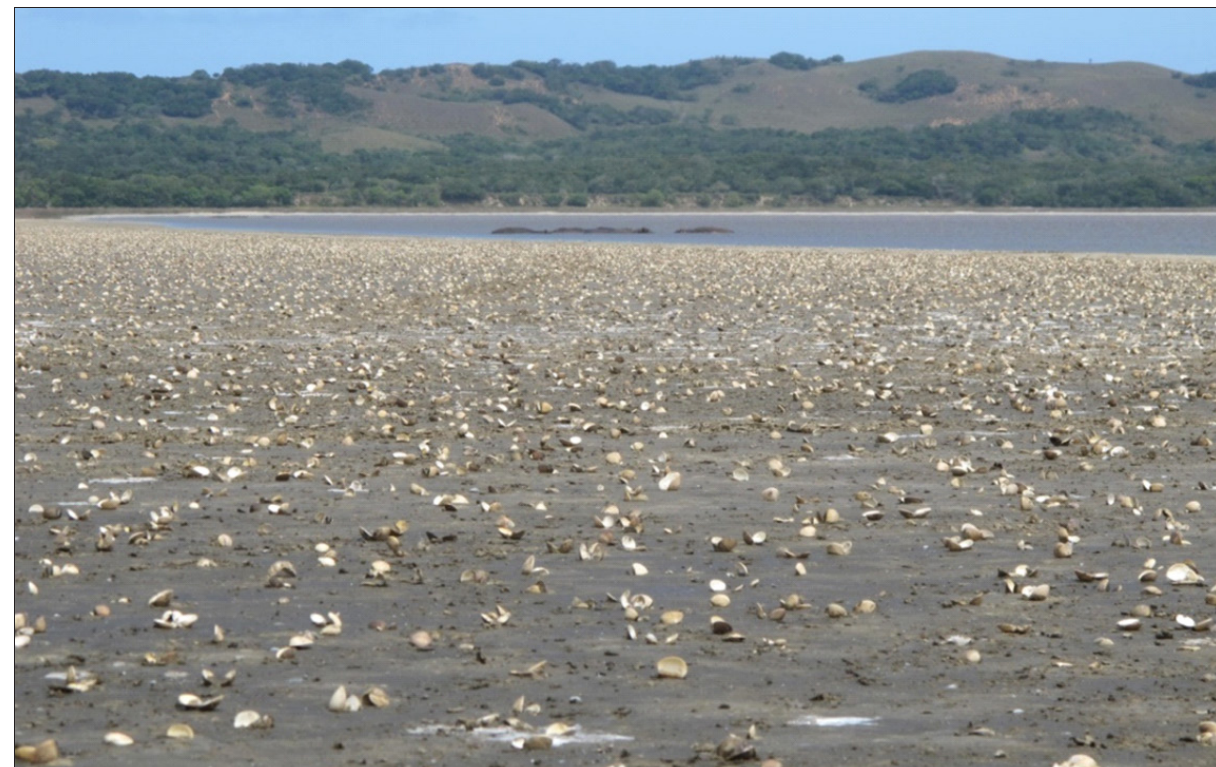
Figure 5: Dense aggregations of exposed and dying Meretrix morphina clams, while water levels receded and hypersaline conditions became re-established around Catalina Bay, Lake St Lucia, in November 2015.